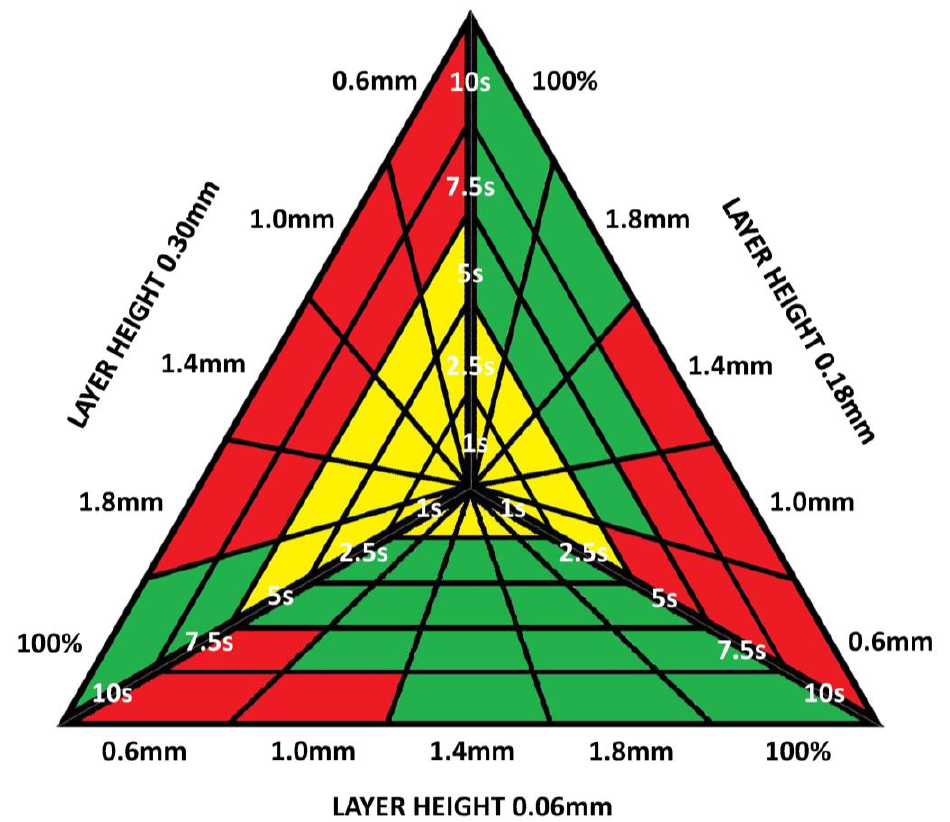
Figure 4. Graph of combination of printing variables and exposure times to dichloromethane that produce a correct surface treatment. In green, combinations of acceptable variables; in red, combinations of rejected variables; and in yellow, combinations of variables that do not eliminate the impression lines.